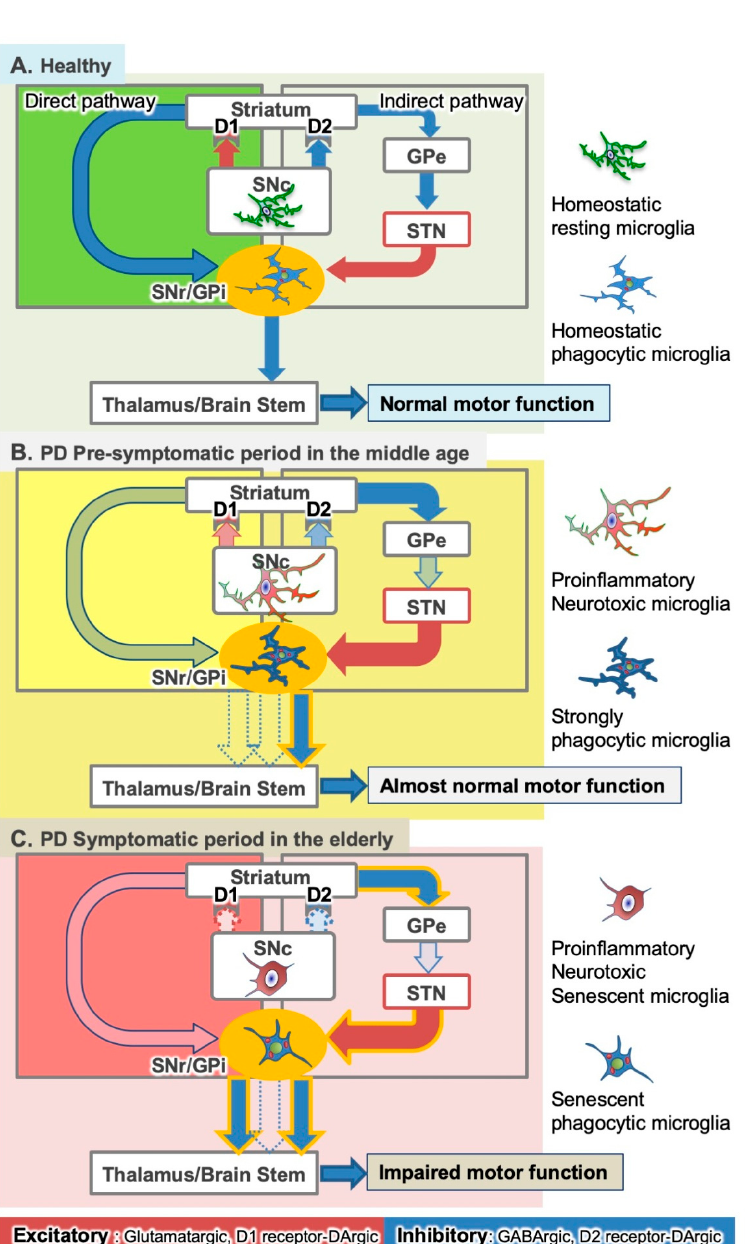
Figure 1. Hypothetical dual roles of microglia in the pathophysiology of Parkinson’s disease (PD). ( A ) In the basal ganglia, homeostatic (or ramified) microglia may play a role in the maintenance of neural circuits both in the substantia nigra (SN) pars compacta (SNc) and basal ganglia outputs (SN pars reticulata (SNr) and globus pallidus pars interna (GPi)) in the normal young adult brain. STN; subthalamic nucleus, GPe; globus pallidus pars externa. ( B ) With age, SNc dopaminergic (DAergic) neuronal degeneration progresses slowly, and microglia undergo gradual proinflammatory activation. In the indirect pathway, DAergic neuronal degradation hyperactivates glutamatergic STN neurons. However, microglia in the basal ganglia outputs prevent the development of PD symptoms by eliminating hyperactive glutamatergic synapses from the STN. ( C ) Finally, most DAergic neurons die, and motor deficits appear. Microglia undergo senescent changes. In the SNc, microglia still exert harmful effects on viable DAergic neurons. In the basal ganglia outputs, senescent microglia cannot normalize the hyperactive